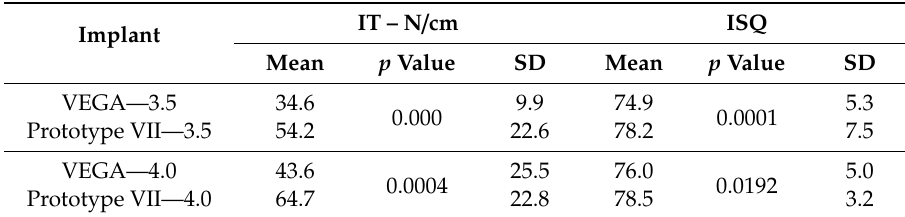
Table 3. Values of the IT and ISQ from the 3rd group—control and Prototype VII with 3.5 and 4.0 mm diameters; the yellow values are the statistically significant